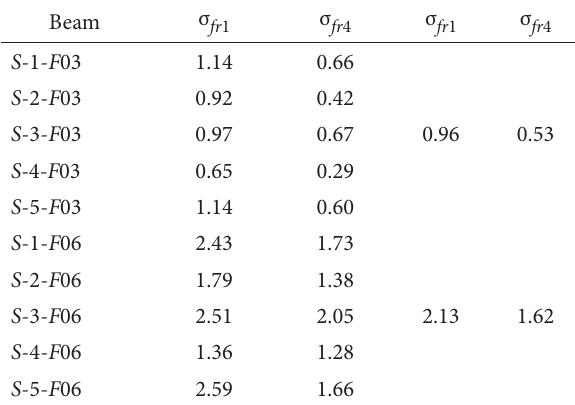
Table 3. Residual strength of the steel fibre reinforced concrete assessed following the Rilem methodology in